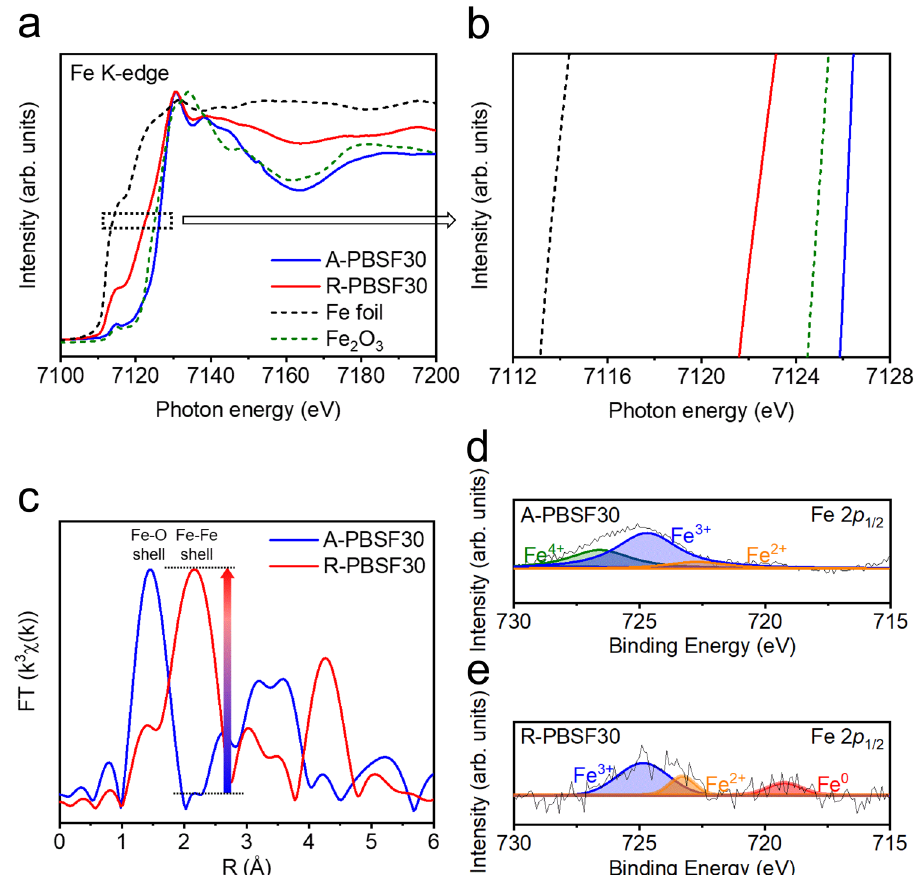
Fig. 4 Oxidation state characterization. a , b Fe K-edge X-ray absorption near-edge structure (XANES) spectra of Pr 0.5 Ba 0.2 Sr 0.3 FeO 3 − δ